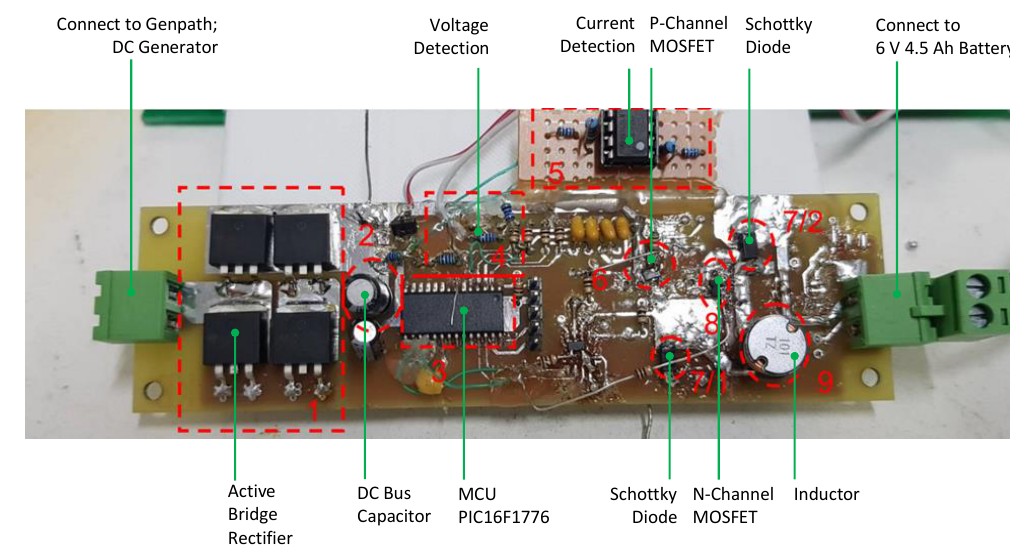
Figure 17. Circuit Diagram of Power Management and Storage System.